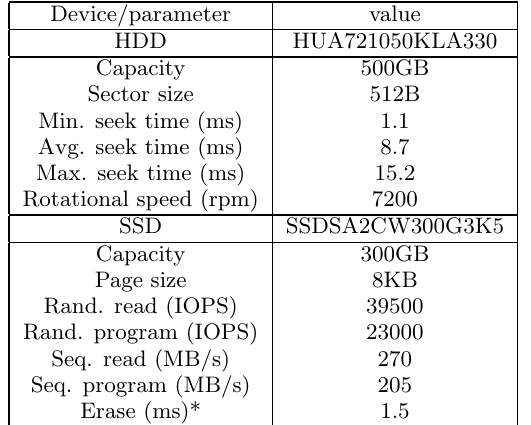
Figure 5: Study of the impact of the workload be- havior over the simulator execution